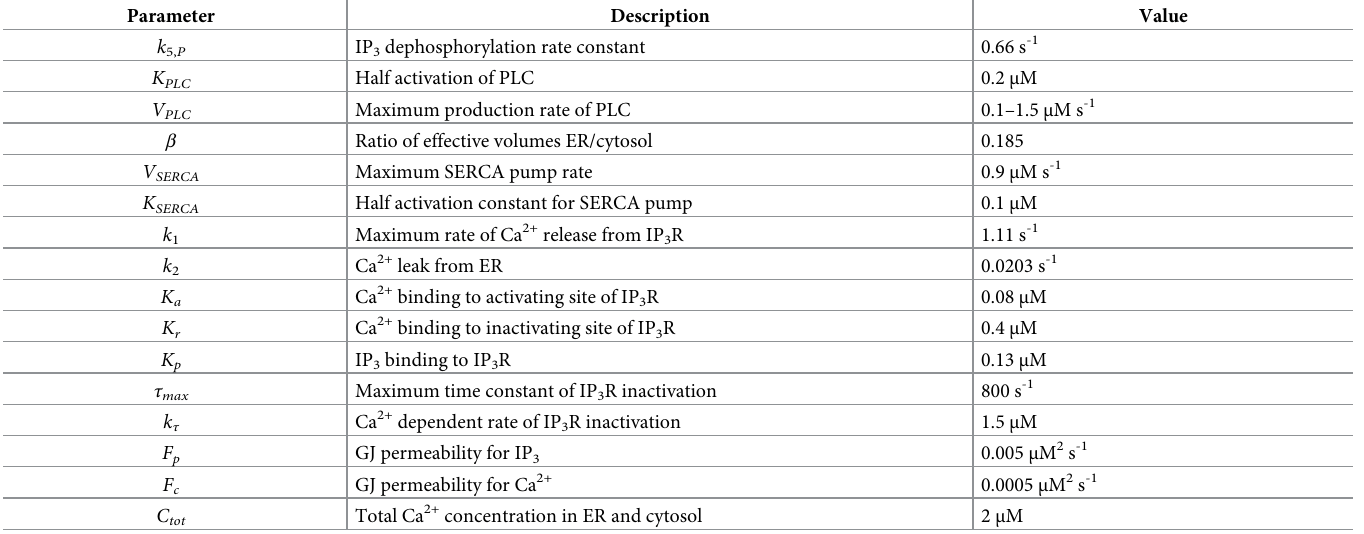
Table 1. Baseline parameters used in the